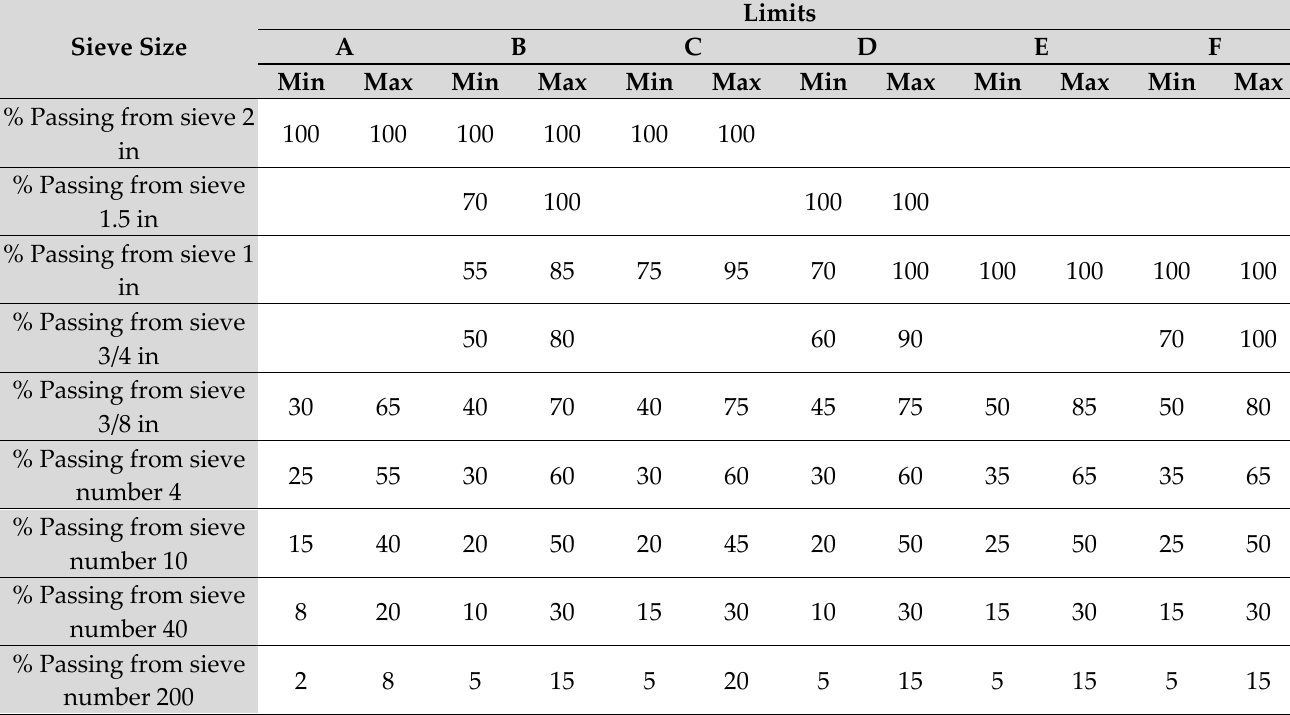
Table 1. Aggregate base gradations used in Egypt [29].